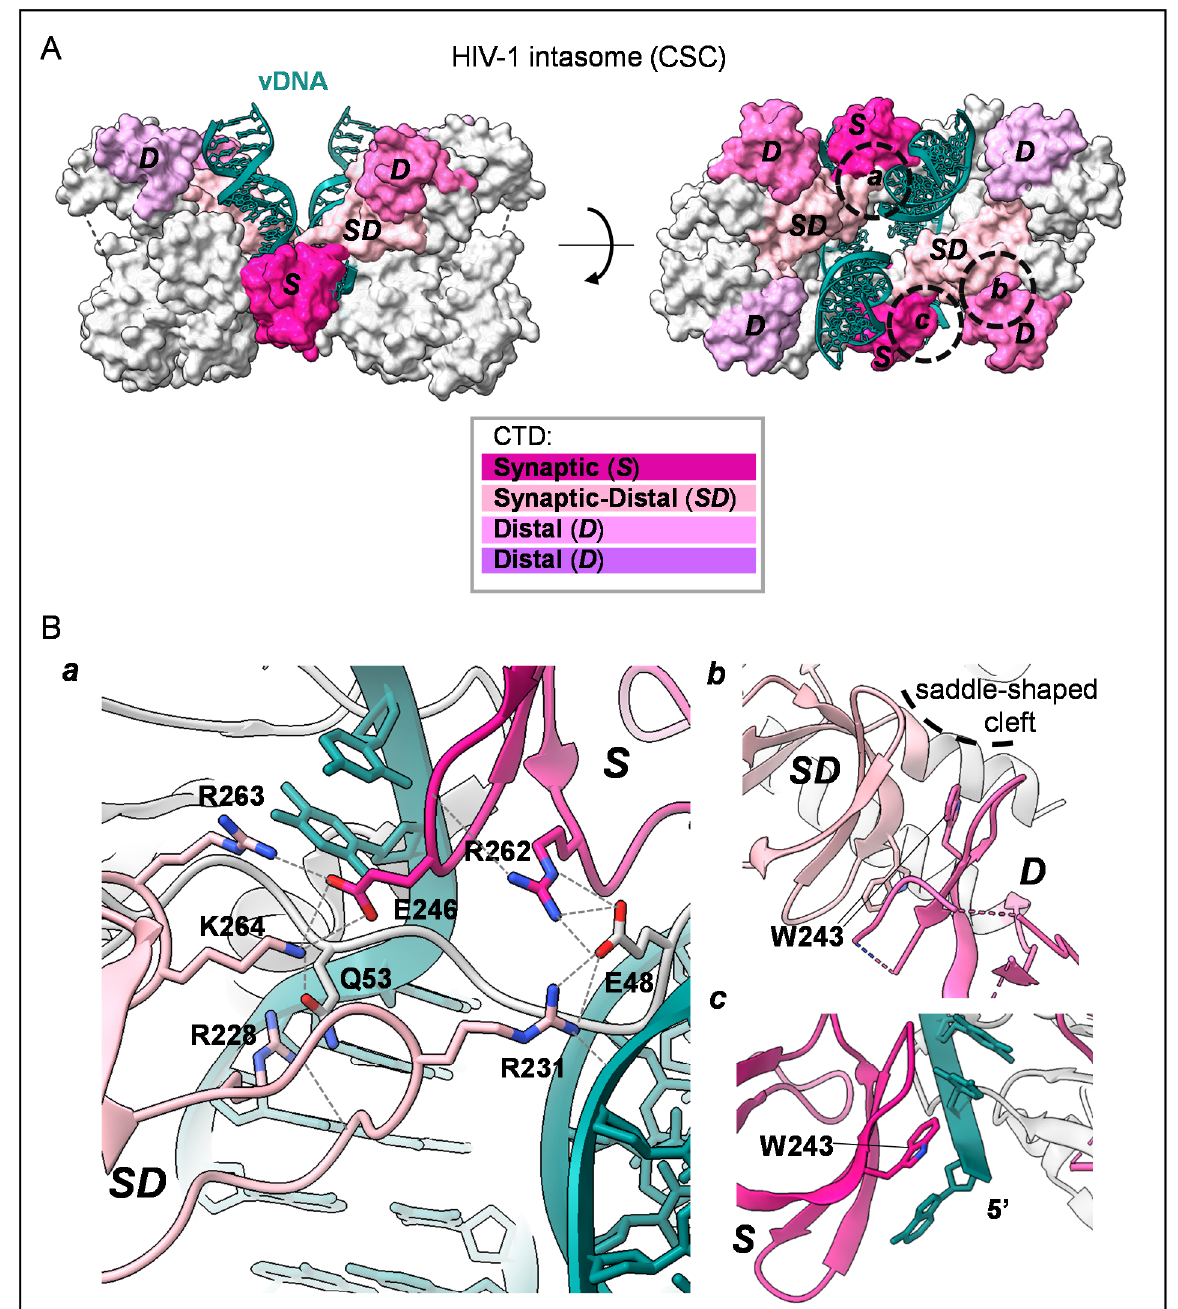
Figure 4. Localization of IN CTD within the HIV-1 cleaved synaptic complex (CSC). ( A ). Surface representation of HIV-1 CSC: only CTDs and vDNA are coloured with four different shades of pink (PDB: 6PUT, [23]). Synaptic CTD (S, dark pink) and synaptic–distal (SD, in light pink) are assembled around vDNA (dark cyan), while distal CTDs (in violet and lilac) are not in contact with vDNA. ( B ). Focus on a, b and c circles of ( a ) interactions between R228, R231, R263 and K264 of distal–synaptic CTD (SD, in light pink), Q53 and E48 of NTD-CCD linker (in grey) and E246 and R262 of synaptic CTD (S, in dark pink); ( b ) dimeric interface between distal–synaptic and distal CTDs: the two W243s comprise the canonical CTD:CTD dimeric interface and are indicated by lines while the saddle-shaped cleft is highlighted with the curved dashed line; ( c ) illustration of the plasticity of the CTD: in the synaptic CTD, W243 interacts with the 5 ′ end of vDNA.